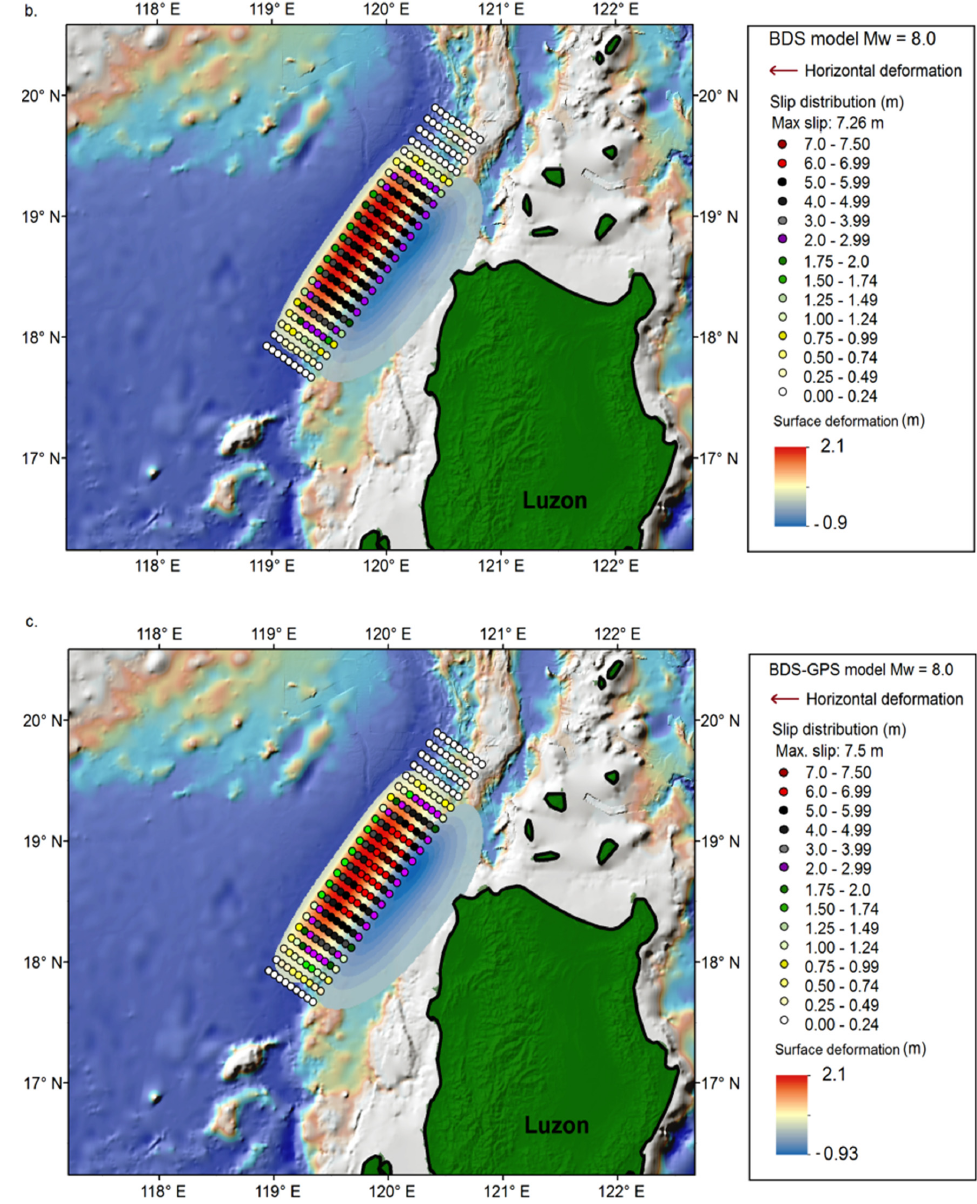
Figure 4. ( a ) Assumed slip distribution (colored dots) and correspondent co-seismic surface deformation for an event with a magnitude of Mw = 8.0 rupturing along the Northern Manila mega-thrust: our forward-model scenario. Red arrows show horizontal displacements computed at the virtual BDS/GPS network (black triangles). The yellow triangle (B1) marks the station from Figure 3. ( b ) Colored dots represent slip distribution as inverted from the simulated BDS-displacements (note, synthetic BDS-displacements include real-time processing noise). Additionally shown is the resulting vertical deformation. ( c ) Same as ( b ), but for the inversion of the joint BDS/GPS displacements.